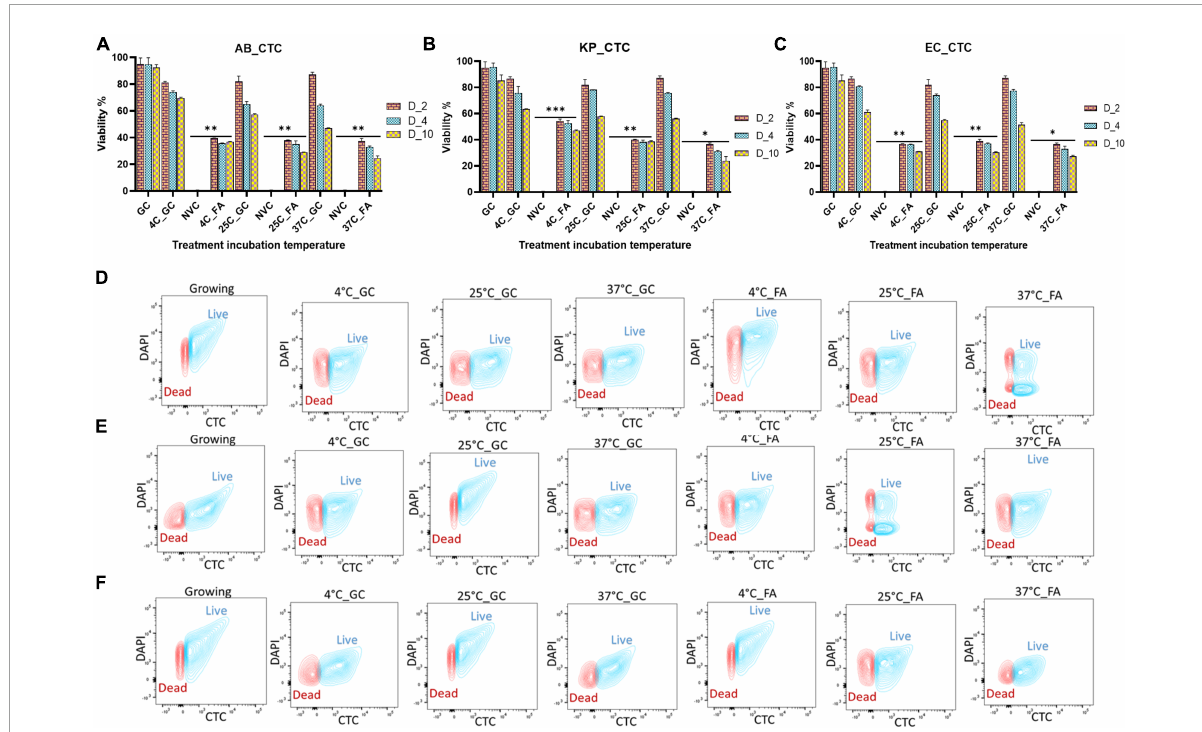
FIGURE3 Determination of respiratory activity as a viability marker after formic acid (FA) treatment. After viable-but-non-culturable (VBNC) confirmation, the respiratory activity of bacteria at the VBNC state was further measured by the flow cytometry on day 2, day 4, and day 10 in Acinetobacter baumannii (A) , Klebsiella pneumoniae (B) , and E. coli (C) at incubation temperatures of 4, 25, and 37 ◦ C. Flow cytometry of untreated and treated cells on day 10 is also shown here in three study isolates Acinetobacter baumannii (D) , Klebsiella pneumoniae (E) , and E. coli (F) . (For day 2 and day 4 data, refer to Supplementary Figure 3 ). A similar proportion of cells are viable on day 4 and day 10 as compared to day 2, but on day 2, cells are growing but they lost viability after day 4. Among all three temperatures, the viability percentage decreased at 4, 25, and 37 ◦ C gradually. Though VBNC induction starts on day 4, there is no significant difference in the viability of bacterial population on day 2 vs. days 4–10. VBNC viability is significant to non-viable control. FA, formic acid; GC, growing control; NVC, non-viable control; 4C, sample incubated at 4 ◦ C; 25C, sample incubated at 25 ◦ C; 37C, sample incubated at 37 ◦ C; D_2, sample tested after 2 days of FA treatment; D_4, sample tested after 4 days of FA treatment; D_10, sample tested after 10 days of FA treatment; AB, Acinetobacter baumannii ; KP, Klebsiella pneumoniae ; EC, E. coli ; growing, actively growing culture from mid-log phage; 4C_GC, 4C culture without treatment at 4 ◦ C; 25C_GC, 25 ◦ C culture without treatment at 25 ◦ C; 37C_GC, 37 ◦ C culture without treatment at 37 ◦ C; 4C_FA, 4 ◦ C culture with treatment at 4 ◦ C; 25C_FA, 25 ◦ C culture with treatment at 25 ◦ C; 37C_FA, 37 ◦ C culture with treatment at 37 ◦ C. ** P -valve < 0.05, *** P -valve < 0.005, and **** P -valve < 0.0005.